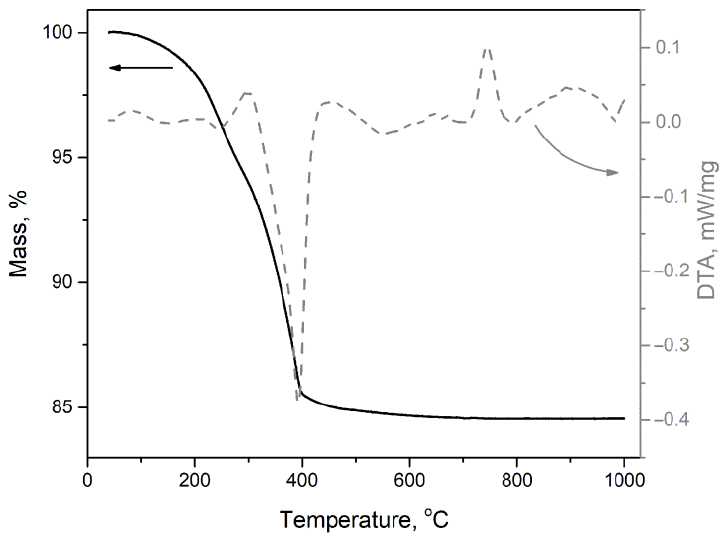
Figure 1. TG and DTA profiles of the GaOOH precursor.